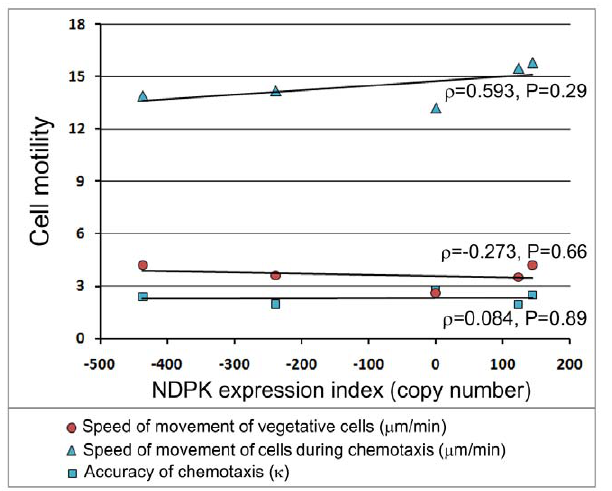
Figure 7. Cell motility is unaffected by the level of NDPK expression. Random motility by vegetative cells and chemotactic motility of aggregation-competent cells of the wild type strain (AX2) as well as two antisense and two overexpression transformants were assayed in three independent experiments. Each point represents the overall mean velocity of movement or the accuracy of chemotaxis ( k ) from all three experiments combined. k is the concentration parameter of the von Mises distribution for directional data [87] and ranges from zero in the case of no orientation to infinity in the case of perfect orientation (all directions identical). Tables S1 and S2 show, in pairwise statistical comparisons, that the slight motility differences amongst the strains were real (statistically significant) but as shown in the Figure they were not correlated with NDPK expression.